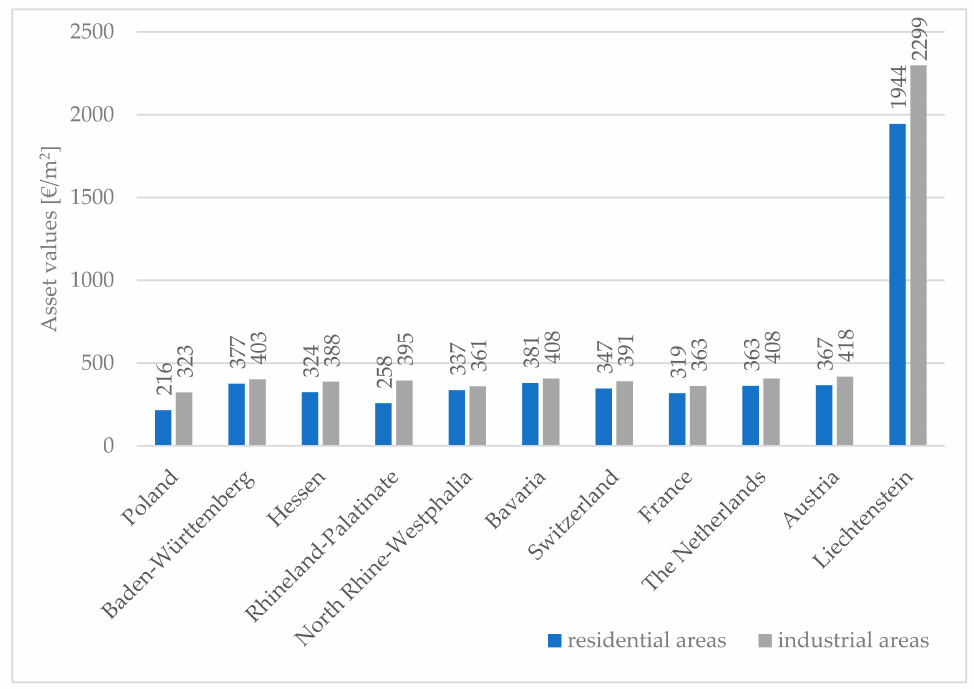
Figure 5. Comparison of asset values determined for Poland and used in the Rhine Atlas, in 2019